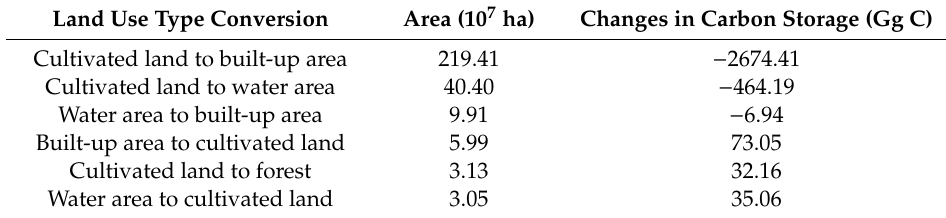
Table 9. The e ff ects of the conversion of the main land-use types on carbon storage from 2000–2010. Land Use Type Conversion